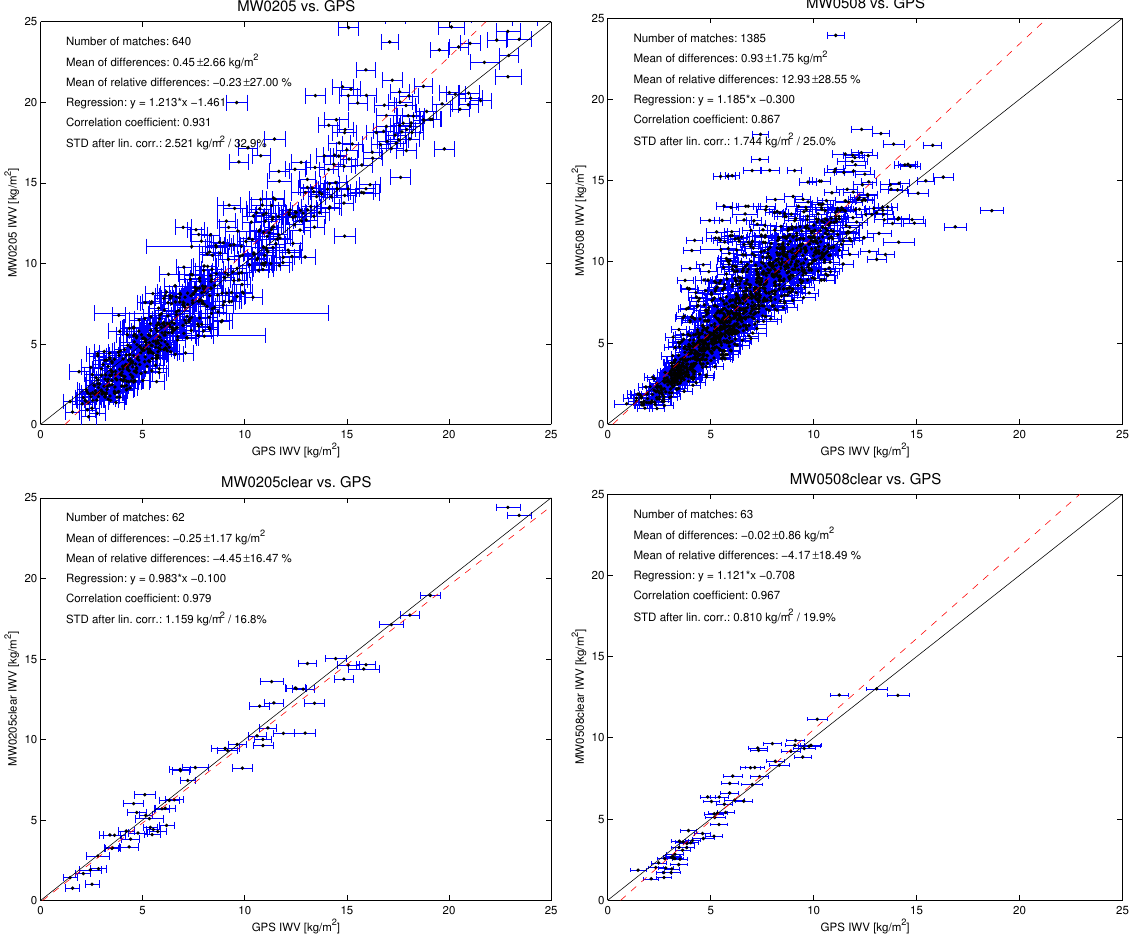
Fig. 7. Scatterplots of other datasets versus GPS: Microwave 2002–2005 (top left), Microwave 2005–2008 (top right), Clear-sky Microwave 2002–2005 (bottom left), and Clear-sky Microwave 2005–2008 (bottom